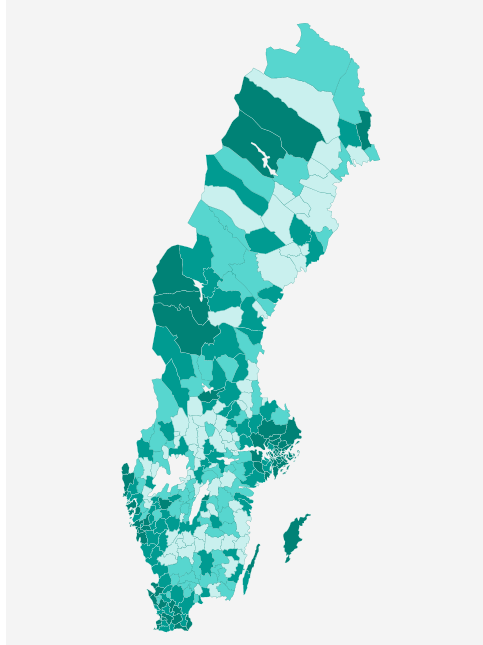
Figure 1: Average number of startups per 1000 inhabitants in Sweden 2011-2014